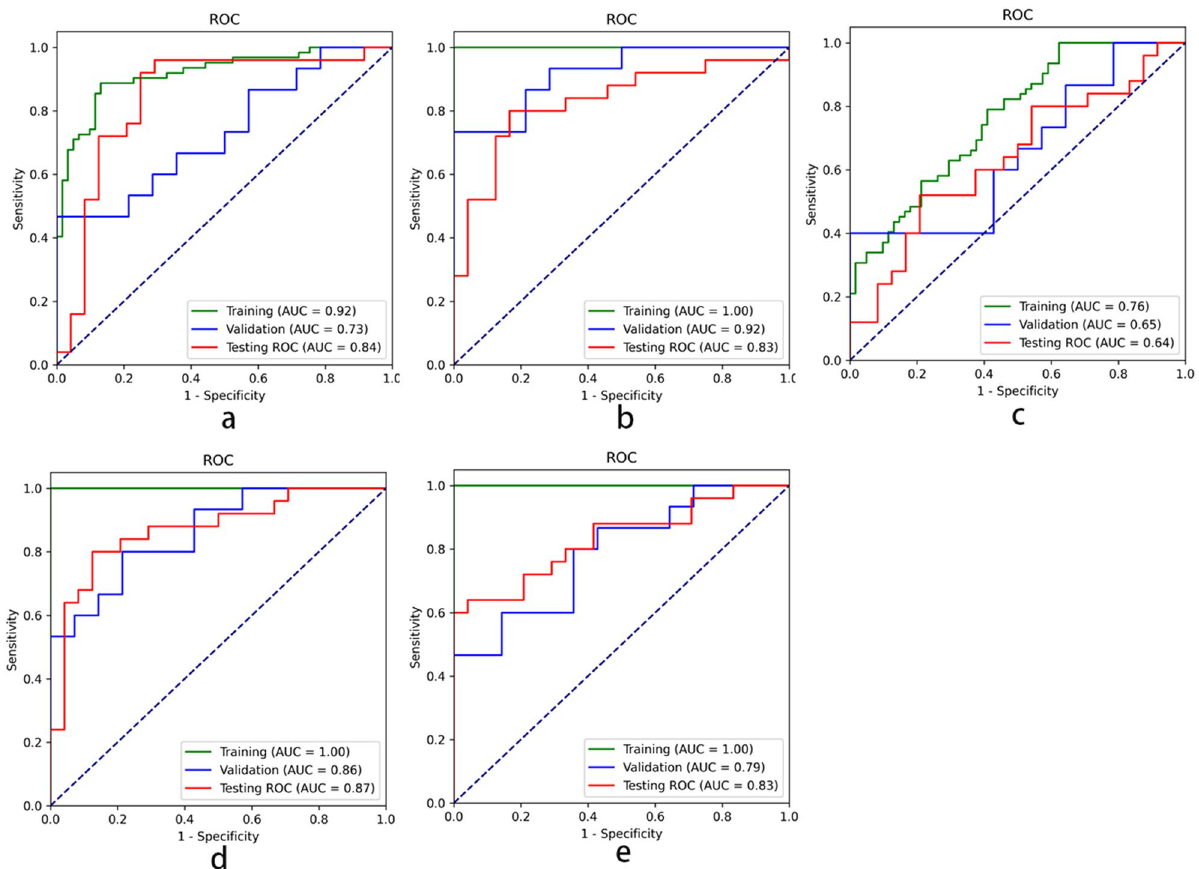
Figure 6. ROC analysis with the trained network for classifying malignancies and borderline tumors in three kinds of dataset. The ROC curves for training (green), validation (blue), and testing (red) dataset on T2WI sagittal MR images ( a ), T2WI coronal MR images ( b ), T1WI MR images ( c ), combining T2WI sagittal and coronal results ( d ), and combining three protocols results ( e ). N